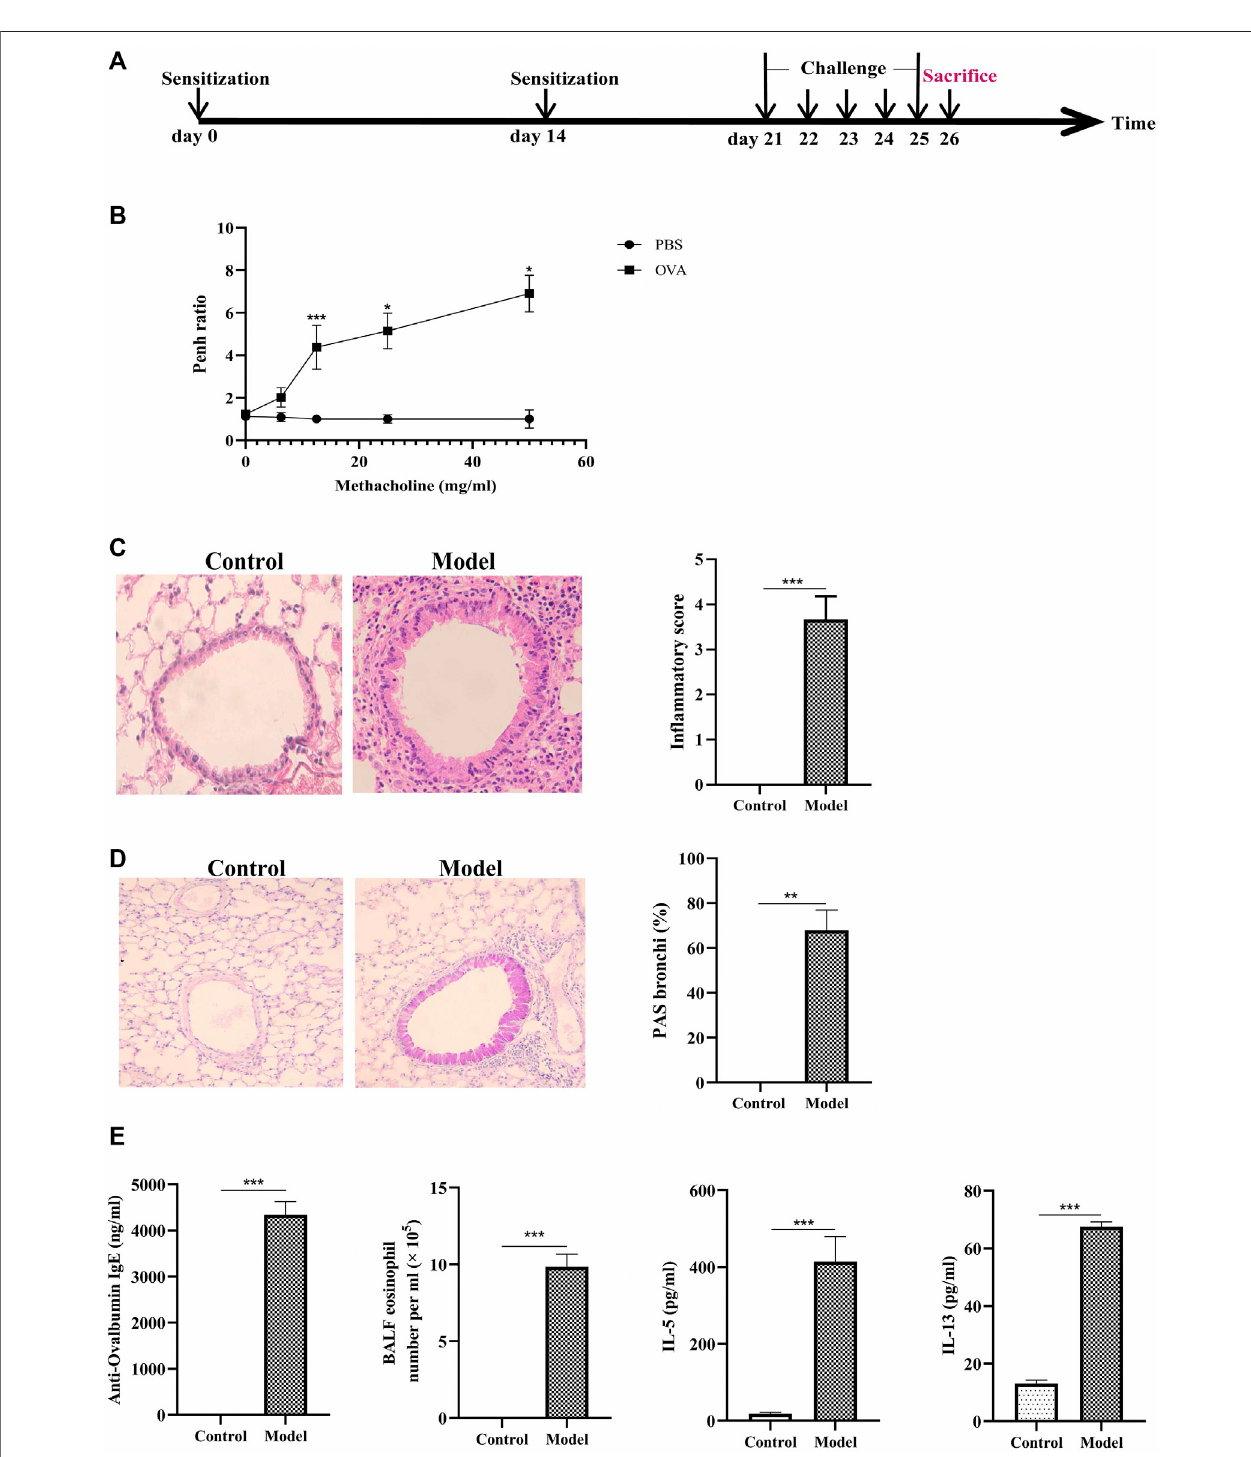
FIGURE 1 | Construction of eosinophilic asthma mice model and evalution of the model. (A) Experimental schema for eosinophilic asthma mice mode; (B) AHR in response to increasing doses of MCh by monitoring penh values. (average Penh over the 5-min time interval with methacholine divided by the average Penh over the 5- min interval with PBS); (C) HE (Hematoxylin/eosin) staining and in fl ammatory score oflung tissue; (D) PASstainingand goblet cell hyperplasia percentage oflung tissue; (E) Eosinophil counts in BALF, the detection of speci fi c OVA-IgE, IL-5, IL-13 in control and model group, BALF was collected 24 h after last challenge, * p < 0.05, ** p < 0.01, *** p ≤ 0.001. All the values are expressed as mean±SEM. n = 4, 5 animals per group.